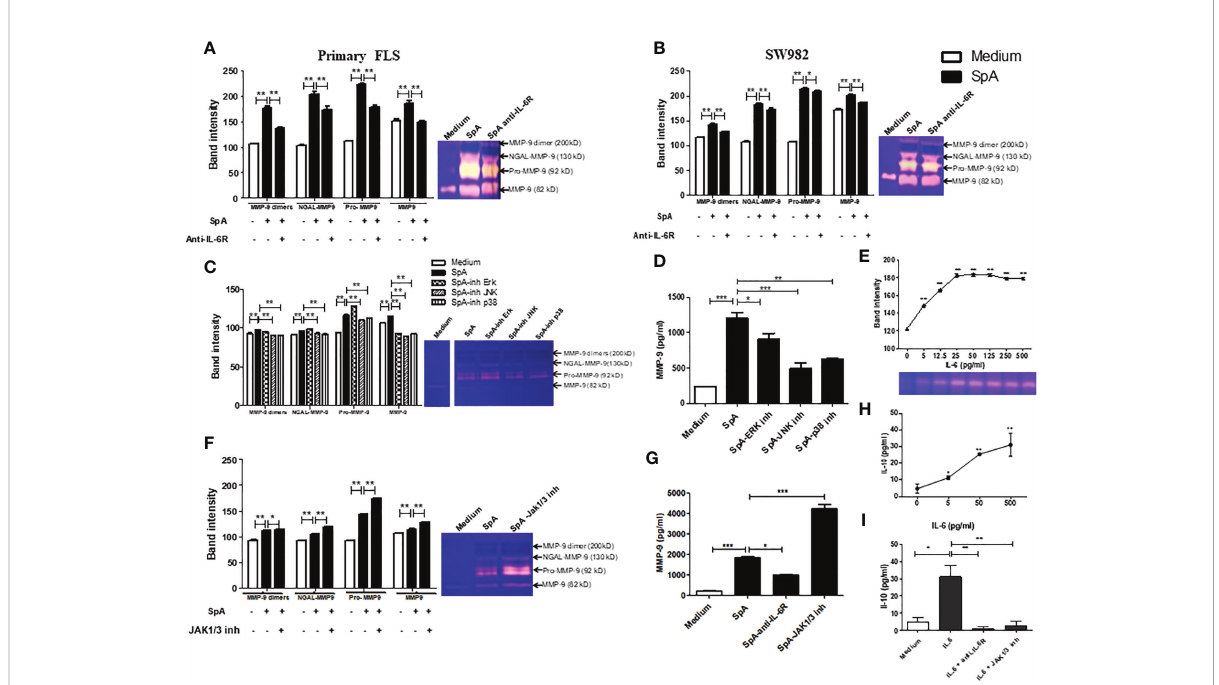
FIGURE 2 IL-6 controls the MMP-9 expression and activity induced by the peripheral SpA synovial microenvironment in FLS. Gelatin zymogram of 48h- supernatants of primary (A) or SW982 (B) FLS stimulated by SpA synovial fl uids in the absence or the presence of anti-IL-6R (tocilizumab). Gelatin-zymography of supernatant of SW982 FLS pretreated with MAPKs (C) or JAK1/3 (F) inhibitors and their respective MMP-9 protein levels (D, G) . Gelatin-zymography of supernatant of IL-6-stimulated SW982 FLS (E) . IL-10 levels secreted by SW982 FLS stimulated with IL-6 (H) or IL- 6 in the presence of anti-IL-6R or JAK1/3 inhibitor (I) . Data of at least two independent experiments. Values are presented as the mean ± SEM. *: p<0.05; **: p<0.01, ***: